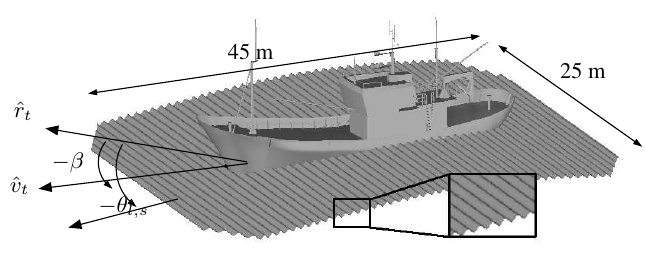
Figure 2. Snapshot of the 3D sea surface model. Note the small scale waves embedded over the surface of the large scale